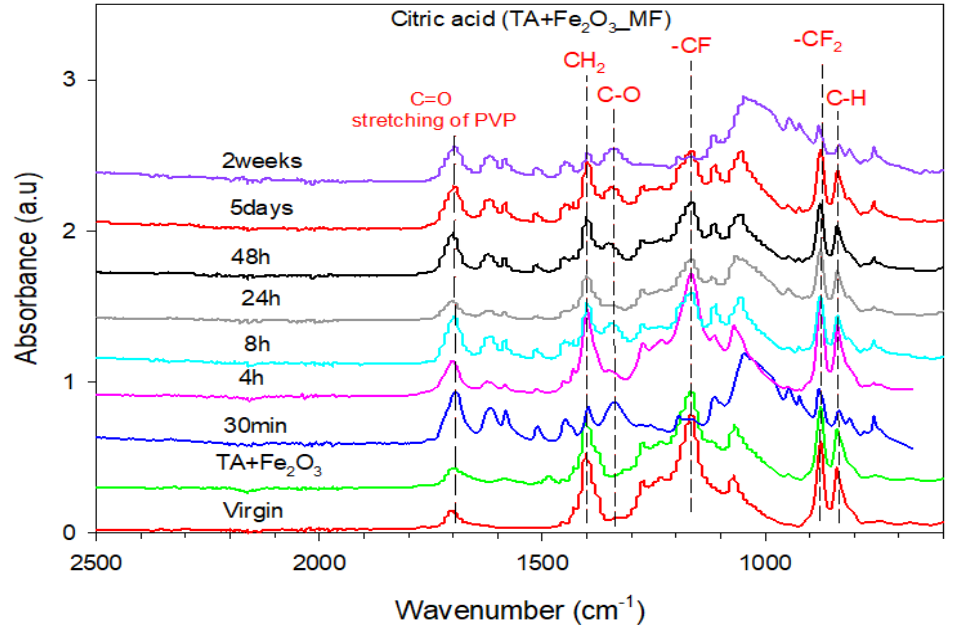
Figure A9. FTIR spectra of PVDF MF virgin and fouled membranes of Tannic Acid with iron oxide solution after soaking in Citric Acid at different accumulative soaking time. Table A1. Measured properties of the MF and UF membranes.